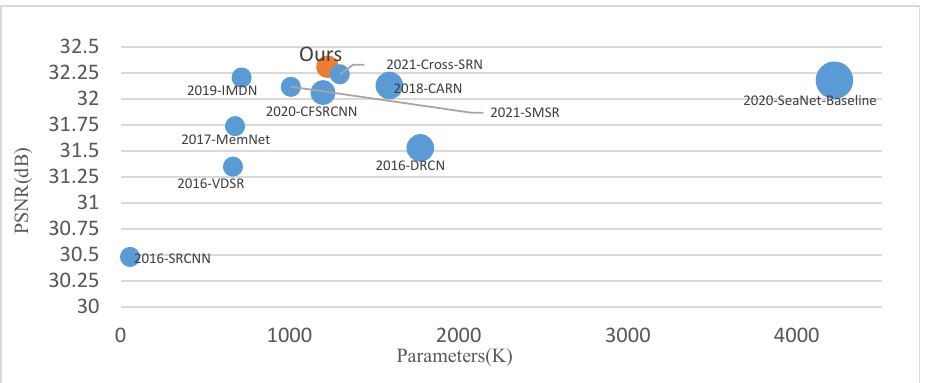
Figure 5. Comparison of the relationship between model parameters and performance (2016-SRCNN refers to the SRCNN algorithm that appeared in 2016).